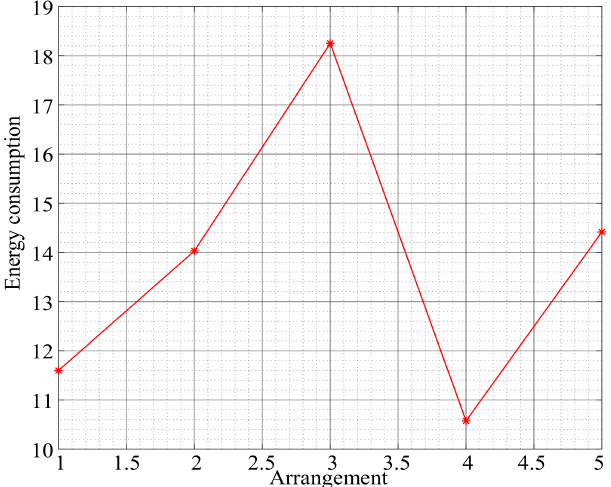
Figure 9. Overall energy variation depending on relay location in different nodes.